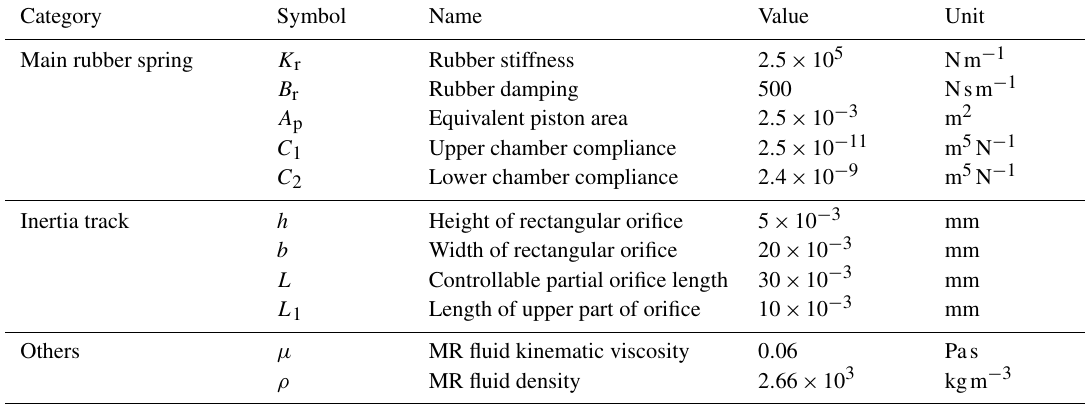
Table A1. Controlled multi-channel semi-active magnetorheological fluid mount